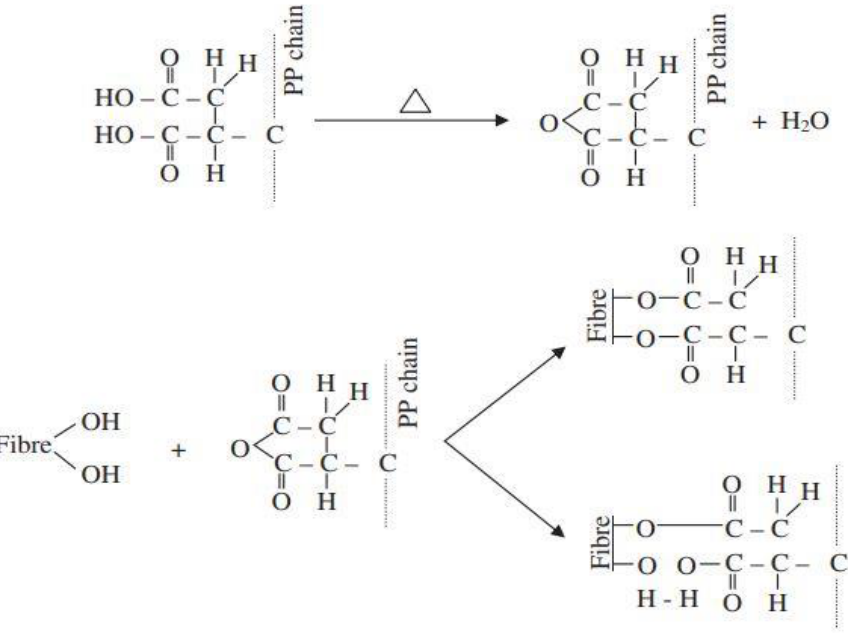
Figure 4. Reactions involved in maleated coupling agent technique (Reprinted from permission from [105]. Copyright 2021 Copyright Elsevier).